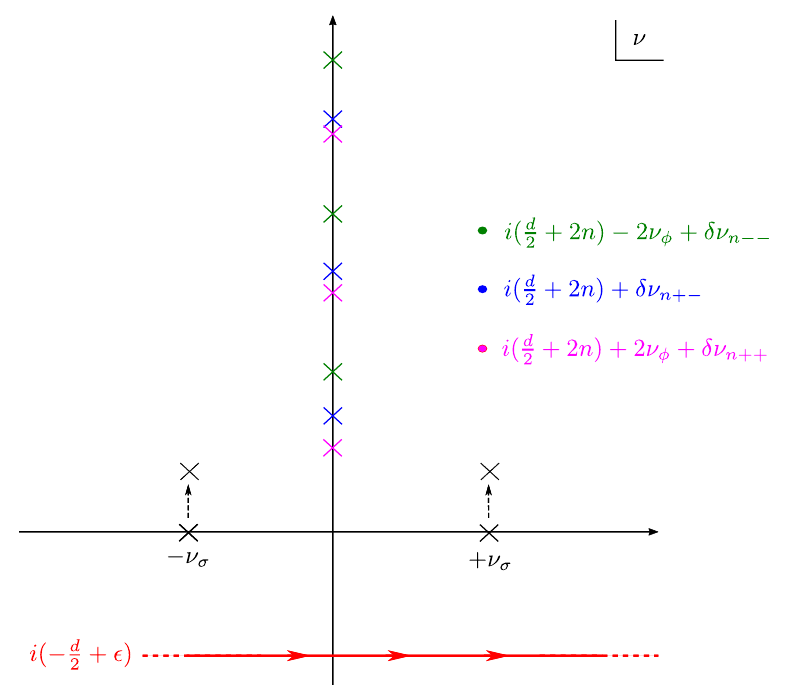
Figure 19 . The analytic structure of the function f 4pt ( ν ) C − ν that encodes the conformal block expansion of the late-time four-point function. The function is holomorphic below the integration contour depicted by the red line. There are three sequences of poles on the imaginary ν axis that correspond to “double-trace operators”. Due to the interaction with the particle σ , their positions receive a shift δν from the equally spaced values in the free theory. Before the resummation of bubble diagrams there are two poles on the real axis associated to particle σ . The dashed arrows denote the shift in the position of these poles induced by the